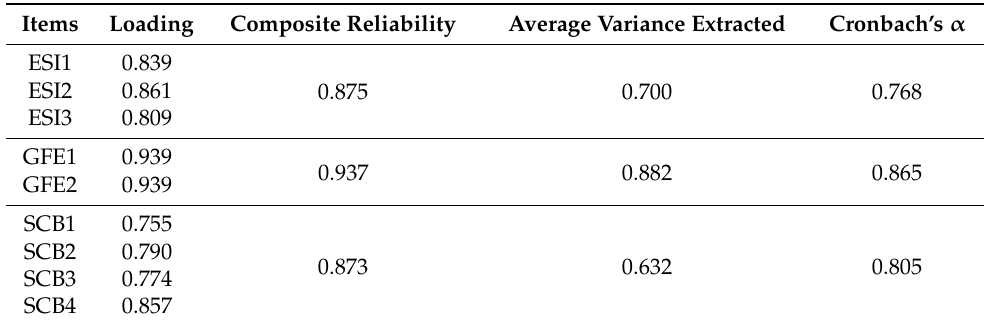
Table 2. Loading, composite reliability and the average variance